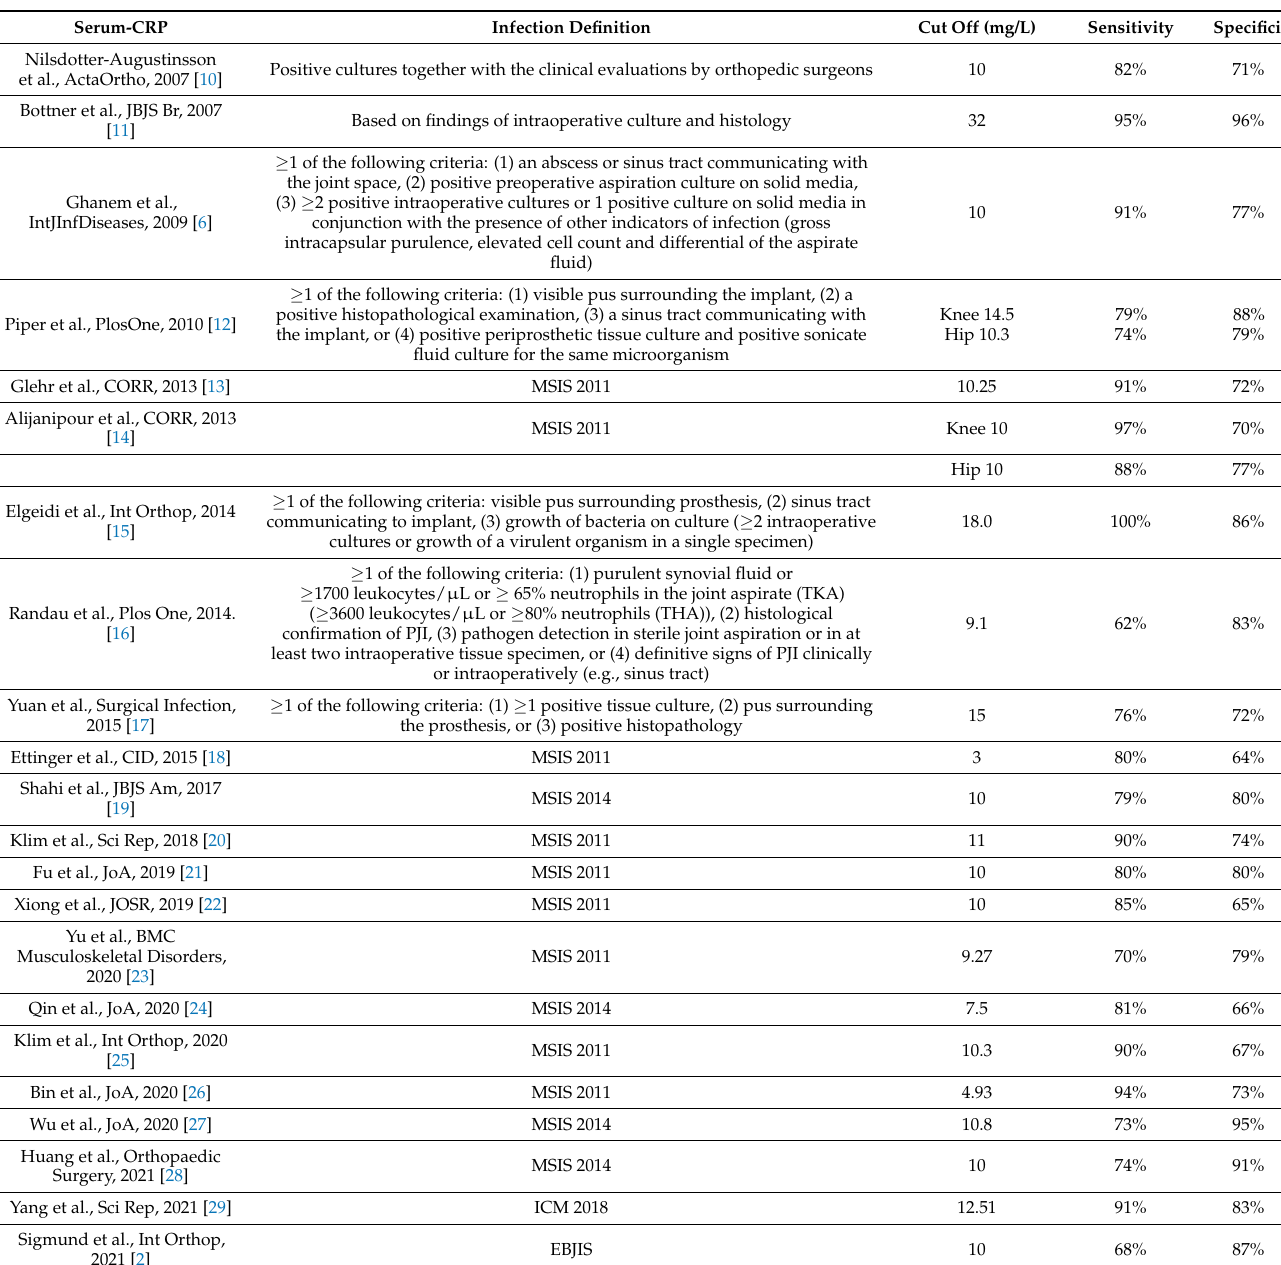
Table 1. Comparison of the literature regarding serum-C-reactive protein (CRP) in the diagnosis of periprosthetic joint infection. Serum-CRP Infection Definition Cut Off (mg/L) Sensitivity Specificity Nilsdotter-Augustinsson et al., ActaOrtho, 2007